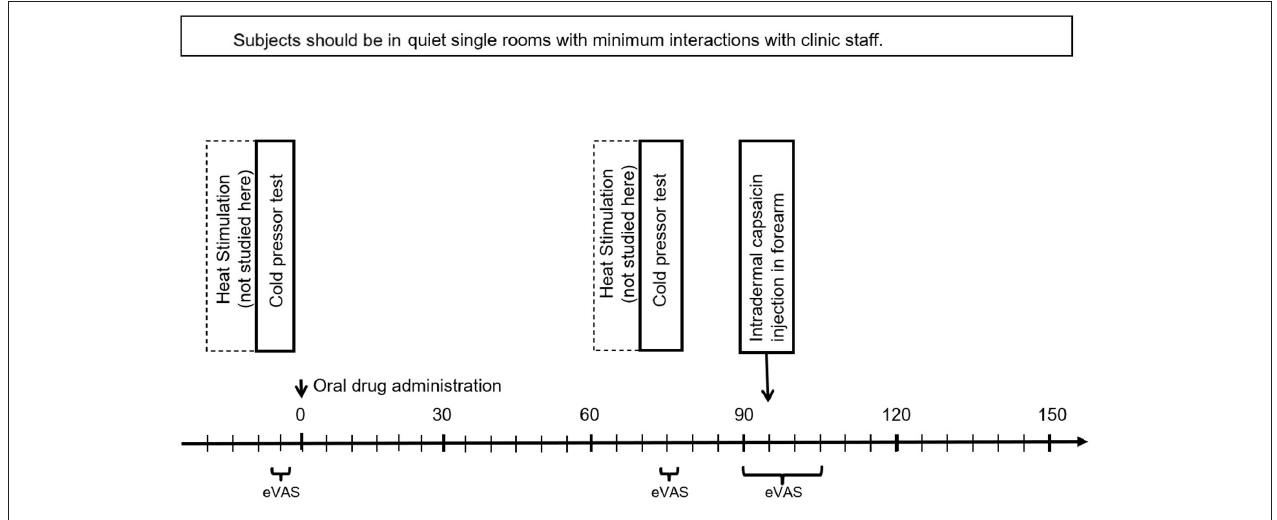
FIGURE 1 | Study protocol, showing three time periods where eVAS was measured. EDA was measured for the entire session ( ∼ 3